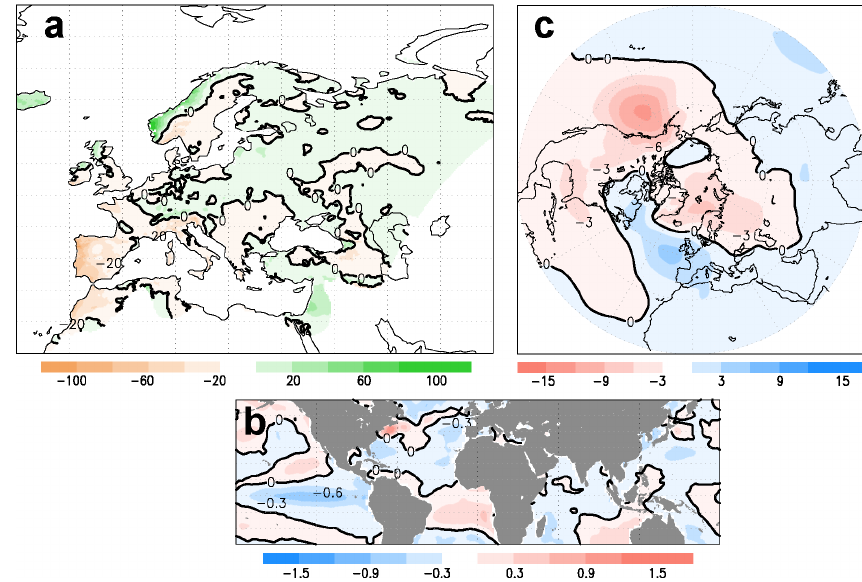
Fig. 5. Composite maps of RR (a) , SST (b) and SLP (c) for anomalous MJO phase 3 in winter. Table 3. As Table 2, but for spring. Only significant values are shown ( ∗∗ p value < 0.01, ∗ p value <